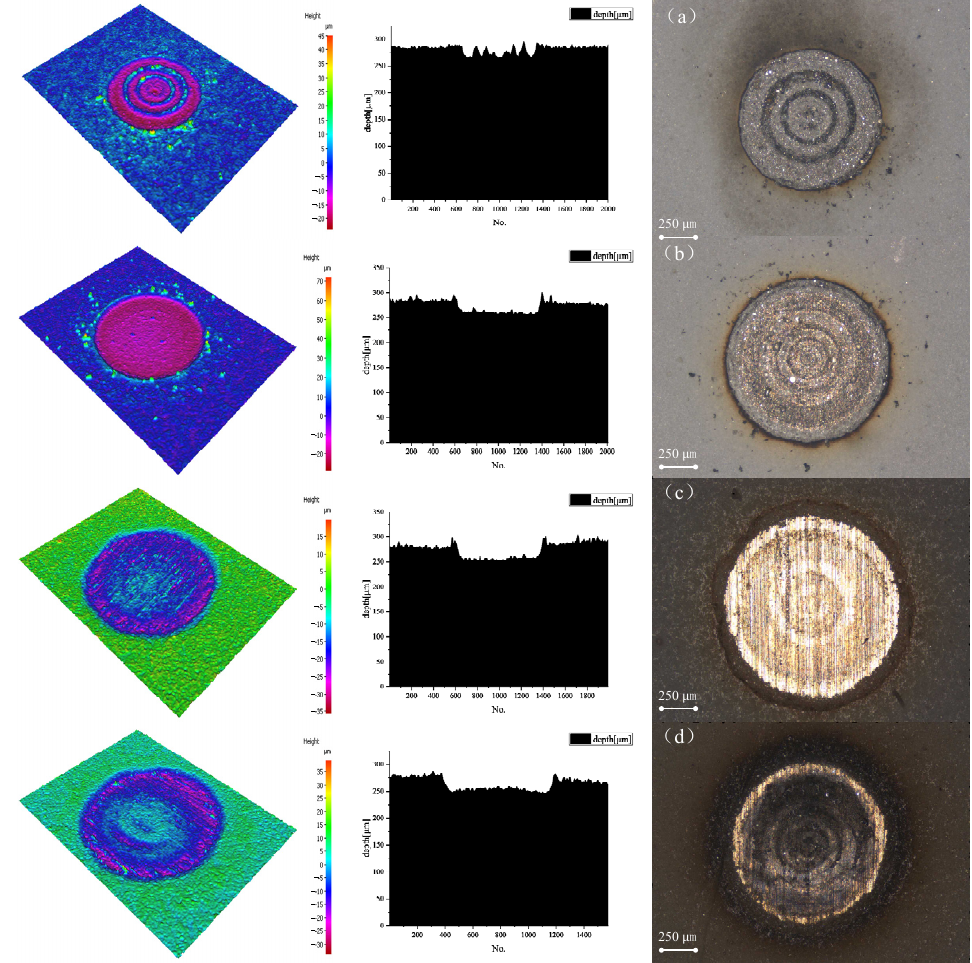
Figure 3. The cleaning effect under different power densities. ( a ) 36.41 W/mm 2 , ( b ) 159.66 W/mm 2 , ( c ) 172.74 W/mm 2 and ( d ) 192.90 W/mm 2 .